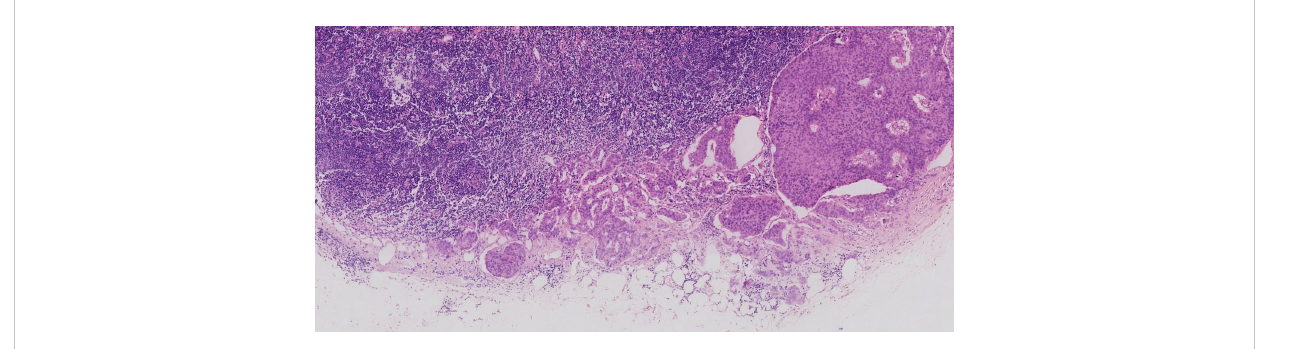
FIGURE 4 Some lymph nodes around the resected intestinal segment were invaded by neuroendocrine tumor (NET)